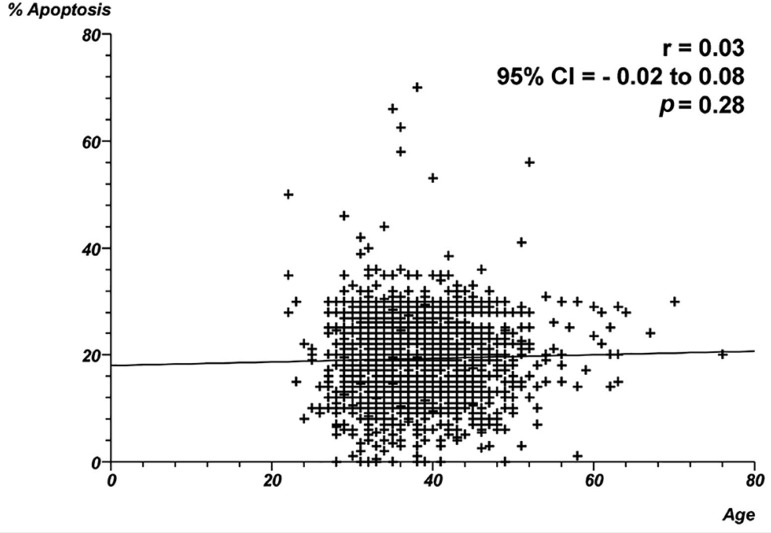
Correlation between male age and proportion of apoptosis. Individual
data points and the regression line are shown. Spearman's rank
correlation coefficient = 0.03; p=0.028.